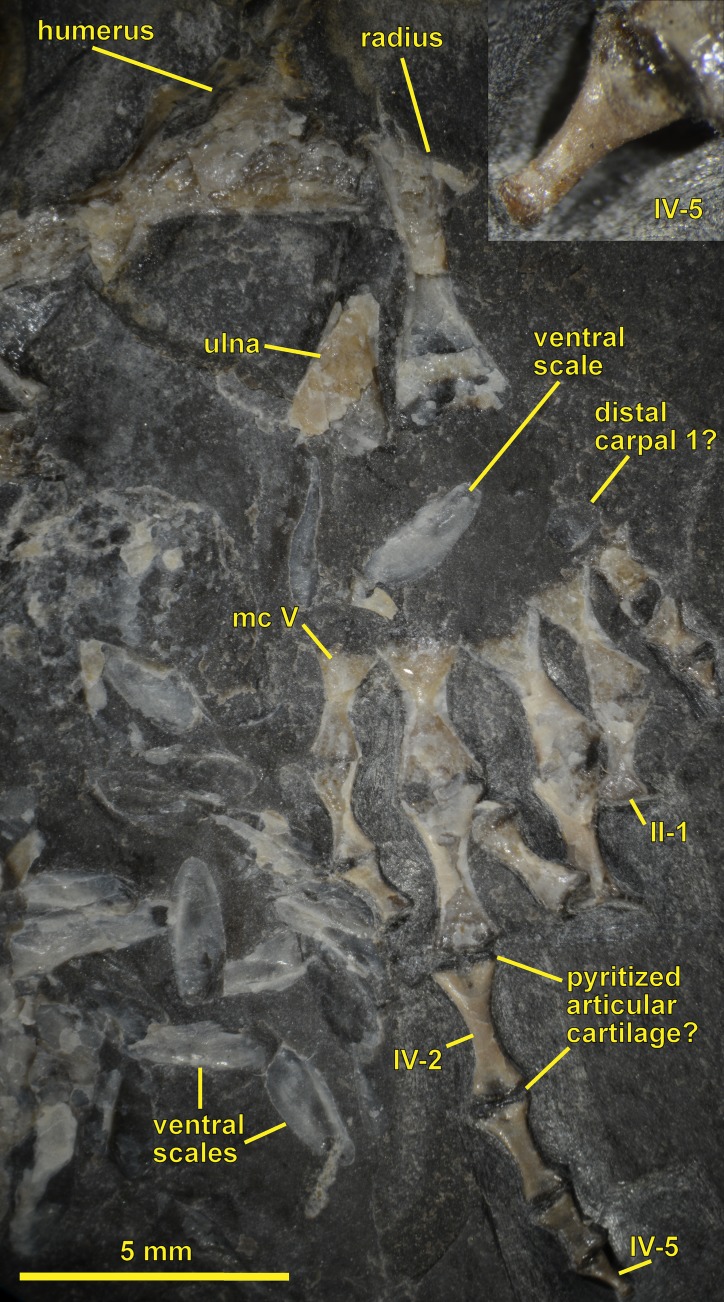
Left forelimb of NMS G 1993.54.1, the holotype of Casineria kiddi, in plantar view.The carpus is unossified except for what may be an incipiently mineralized distal carpal 1. The inset shows phalanx IV-5 at a higher magnification (photographed from a different angle; length approximately 1 mm); note that the tip, although curved plantarly, is blunt, unlike in amniotes and contrary to Paton, Smithson & Clack (1999). Abbreviation: mc, metacarpal. The scale bar is approximate. Photos taken by D. M.